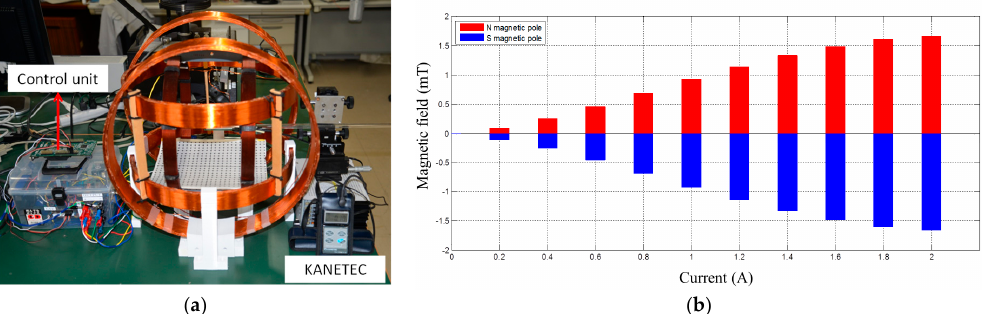
Figure 7. Measurement results ( a ) Measurement system; ( b ) Relationship between the current and magnetic field.